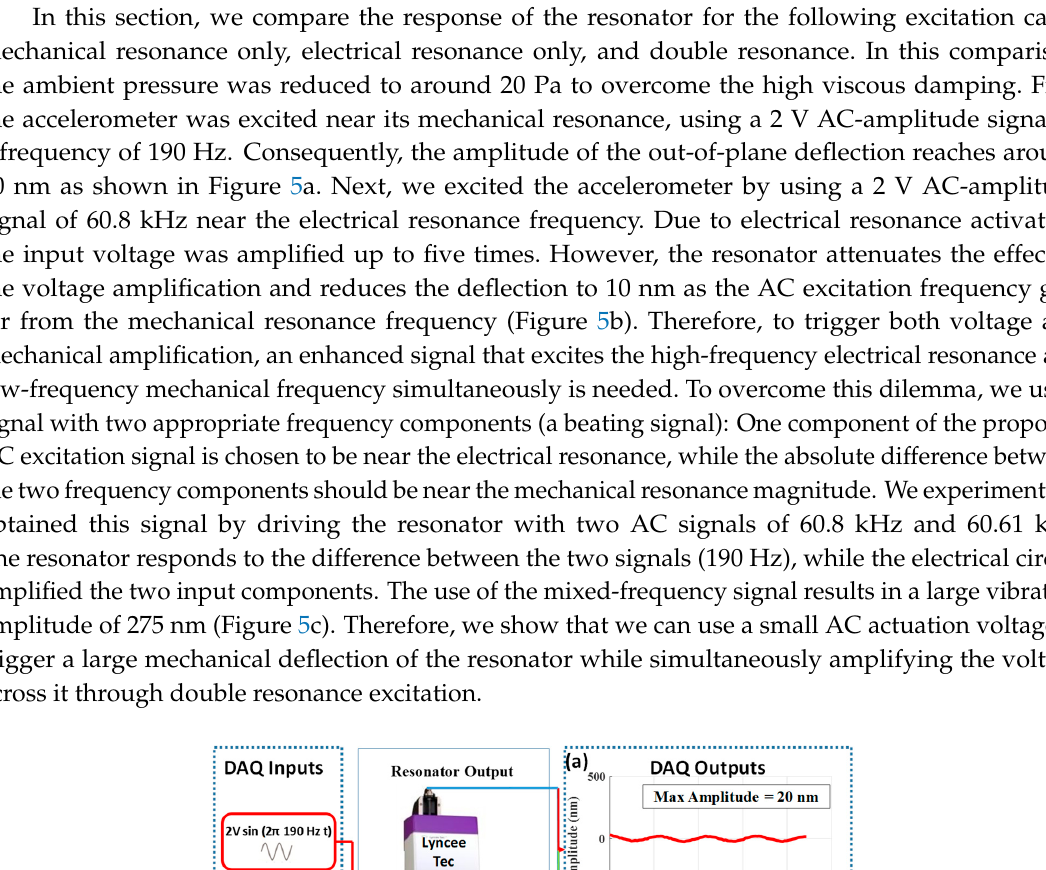
Table 2. The electrical properties of the resonator.